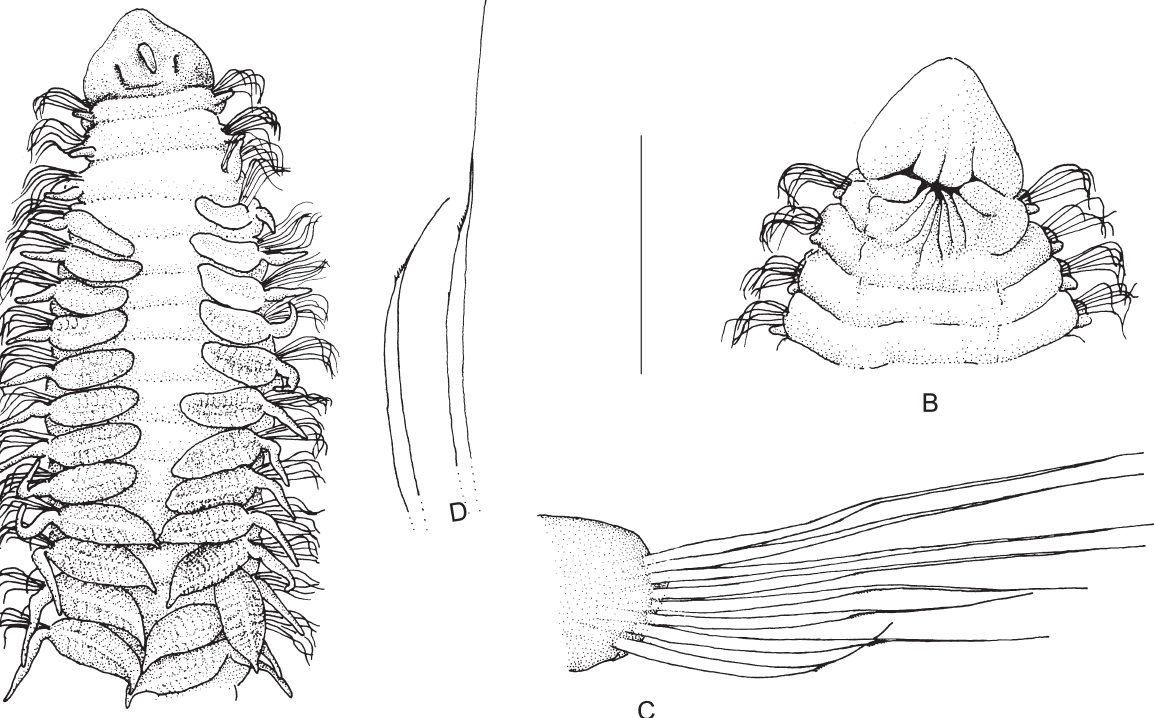
Fig . 22. – Aricidea ( Allia ) nekanae n. sp.: A, anterior region, dorsal view; b, anterior region, ventral view; c, neuropodium, modified ventral chaetae, chaetiger 40; D, modified ventral chaetae, chaetiger 40. Scale bar: A 665 µ m; b 455 µ m; c 75 µ m; D 65 µ